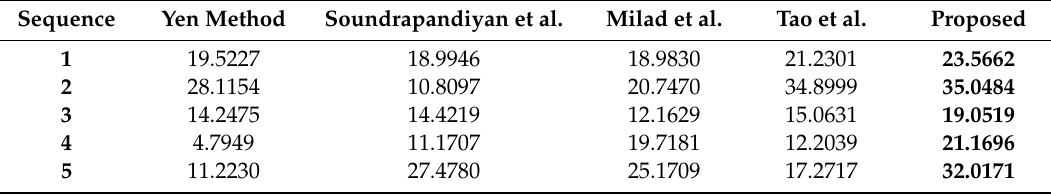
Table 3. Average peak signal noise ratio (PSNR) (in dB) results for the five methods. Sequence Yen Method Soundrapandiyan et al. Milad et al. Tao et